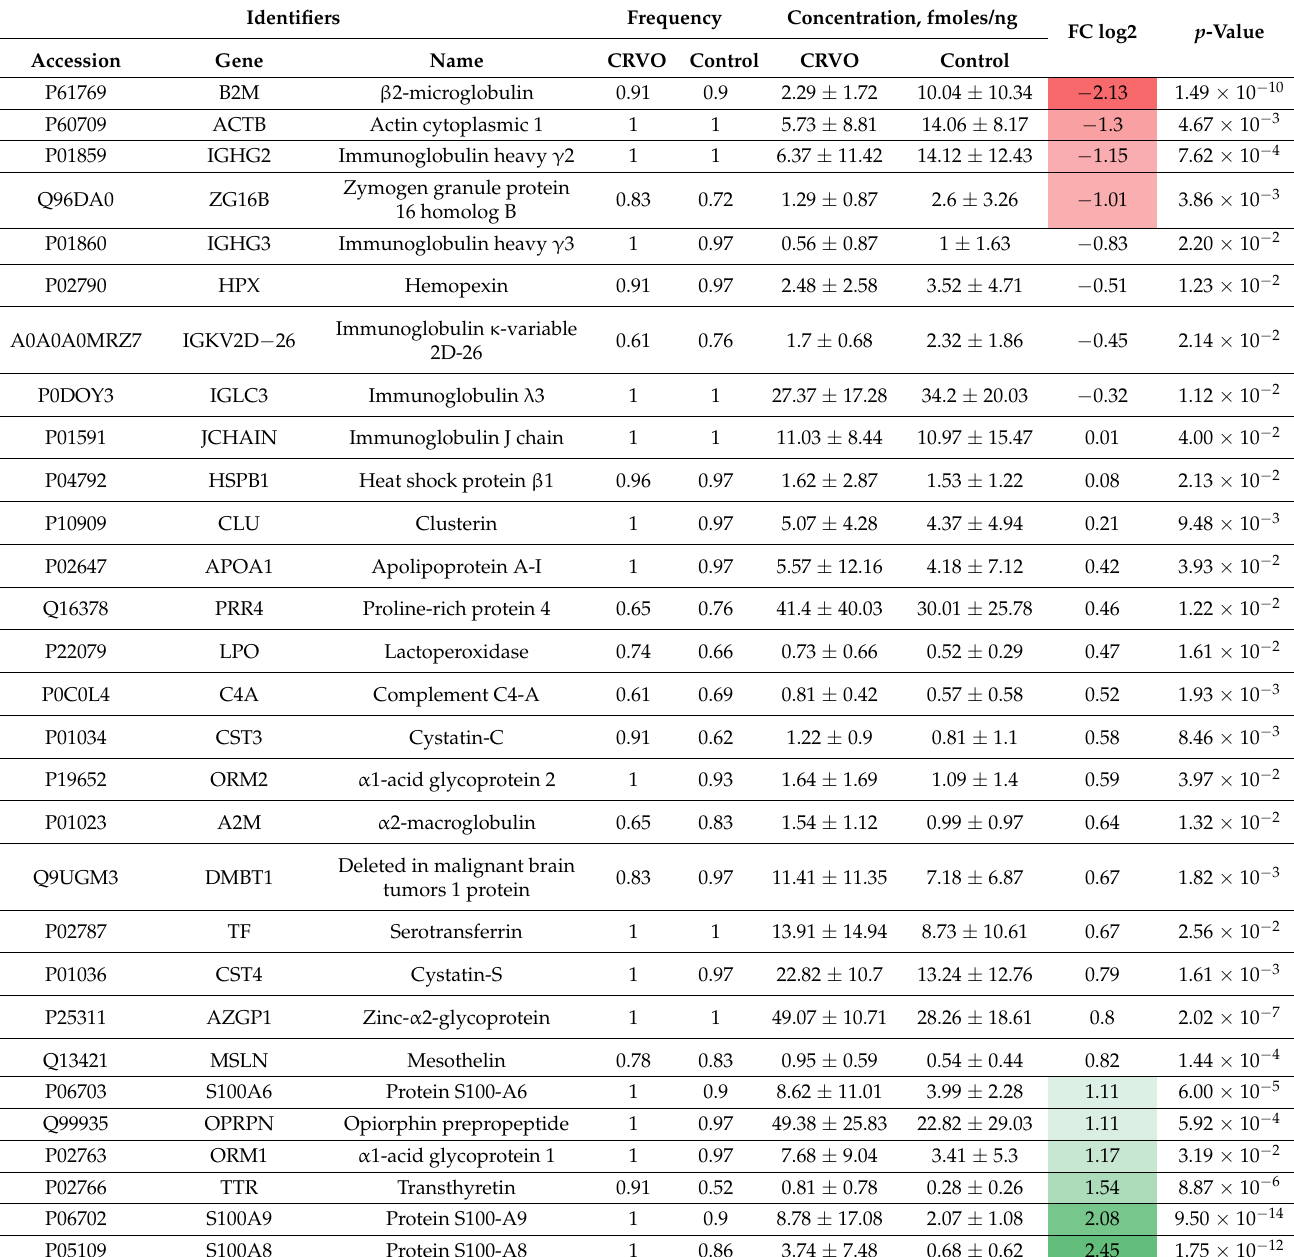
Table 1. Quantitative assessment of the common part of the proteome ( p < 0.05). Due to the frequency percolation (more than 0.6 value within each group) being applied before the selection of significant proteins, the estimated concentration is designed as a median value with an interquartile range (IQR). The protein concentration is estimated as an amount of certain protein (in fmoles) per one ng of total protein on-column loading (fmoles/ng). The total amount of protein on-column loading was 3 (three) − 1) are color µ g per sample. Proteins falling off the FC cut-off level (log 2 (FC) > 1 or log 2 (FC) <